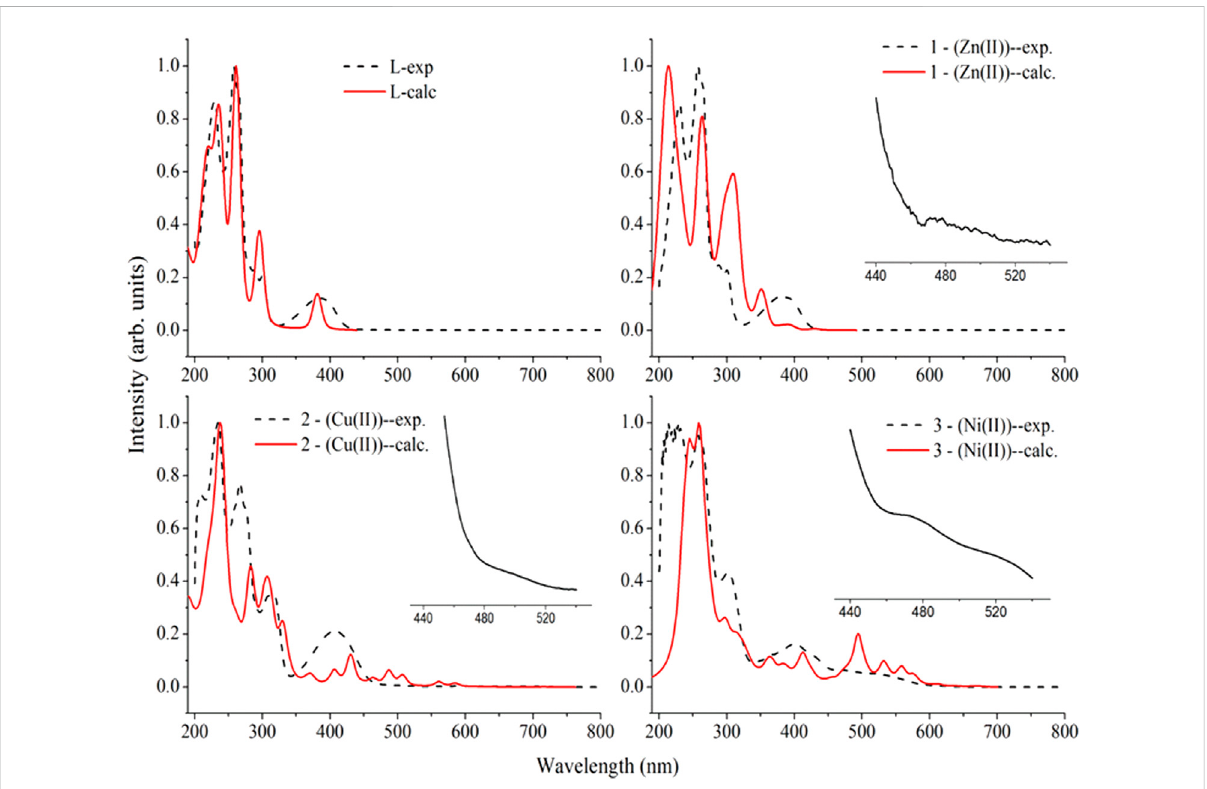
FIGURE 1 Comparison of the experimental absorption wavelengths with the corresponding TD-B3LYP-GD3/6 – 311++G (d,p)/LanL2DZ/IEF-PCM/ methanolcalculatedresultsoftheligand( H 3 L ),theZn(II)( 1 ),Cu(II)( 2 ),andNi(II)( 3 )complexes.Thecalculatedabsorptionmaximawereredshiftedby 20 nm for better comparison with the experimental results. Insets are experimental plots for the range between 440 and 540